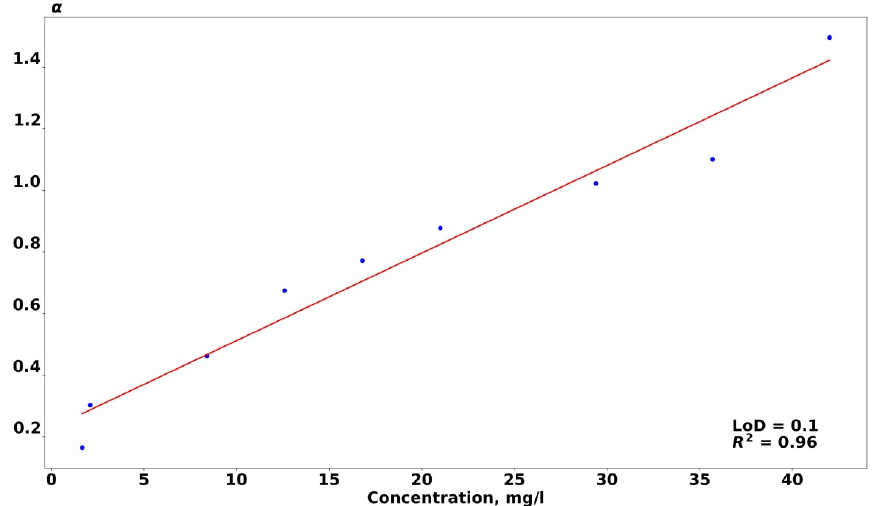
Figure 10. The calibration function for the DMA solution by α as the integral parameter.